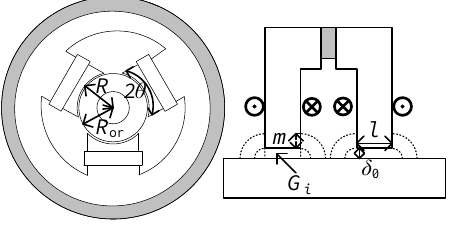
Figure 6. Dimensions of each part of the three-pole radial HMB.